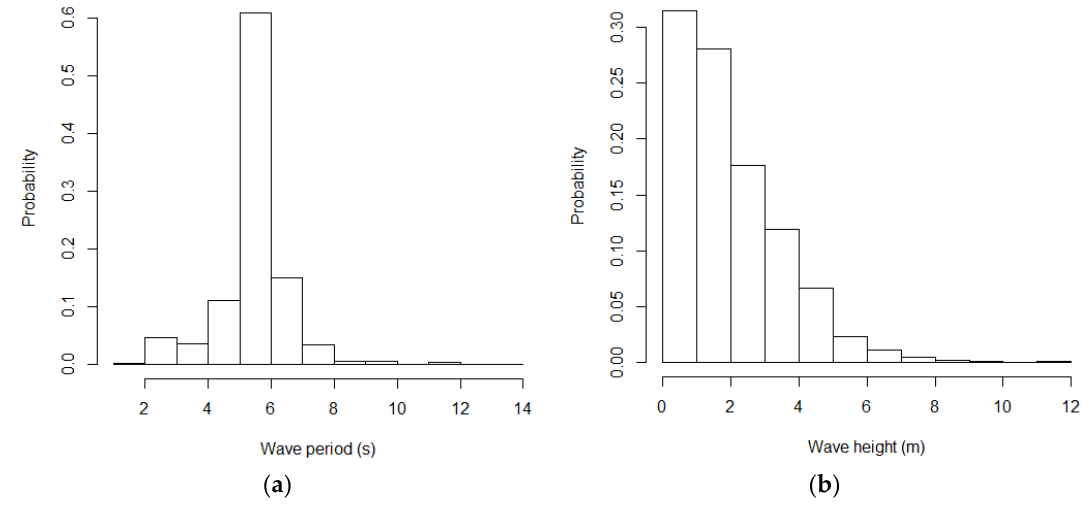
Figure 5. Histogram for ( a ) wave period and ( b ) wave height.